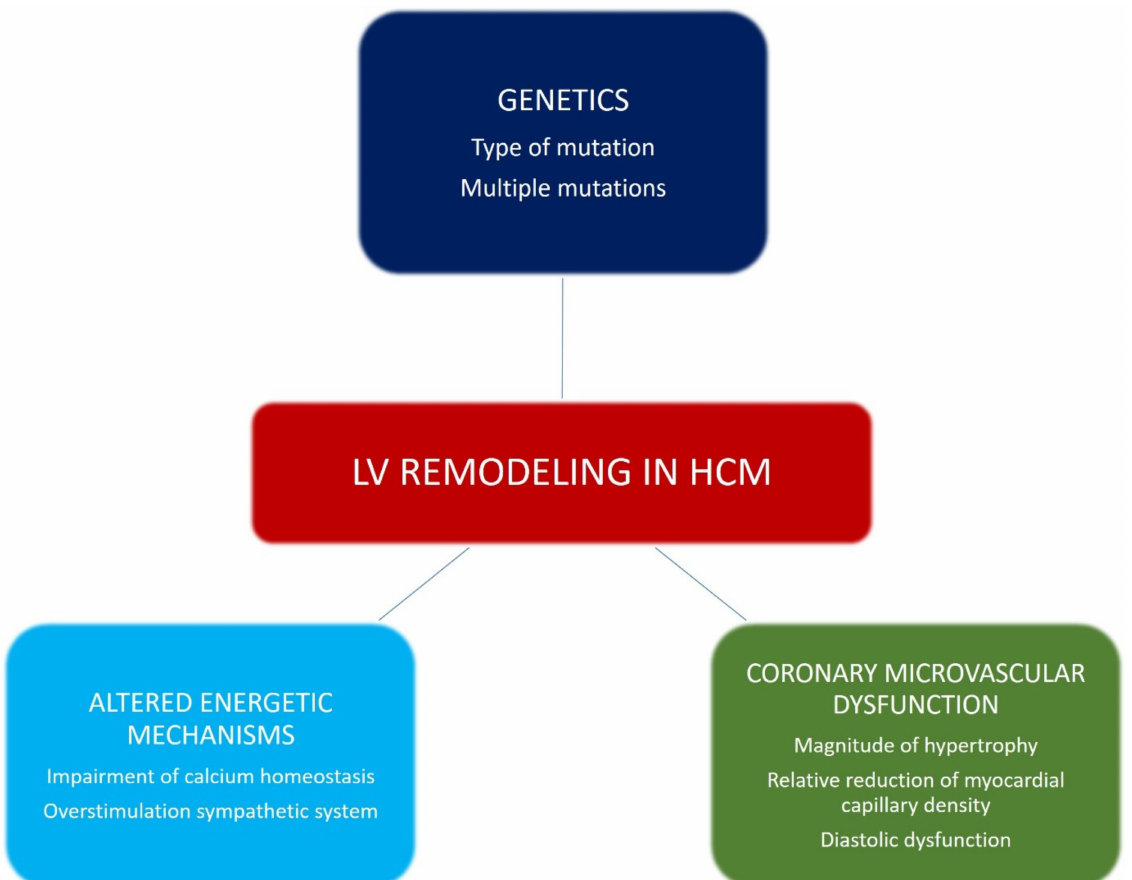
Figure 1. Pathophysiological mechanisms involved in left ventricular (LV) remodeling in hypertrophic cardiomyopathy